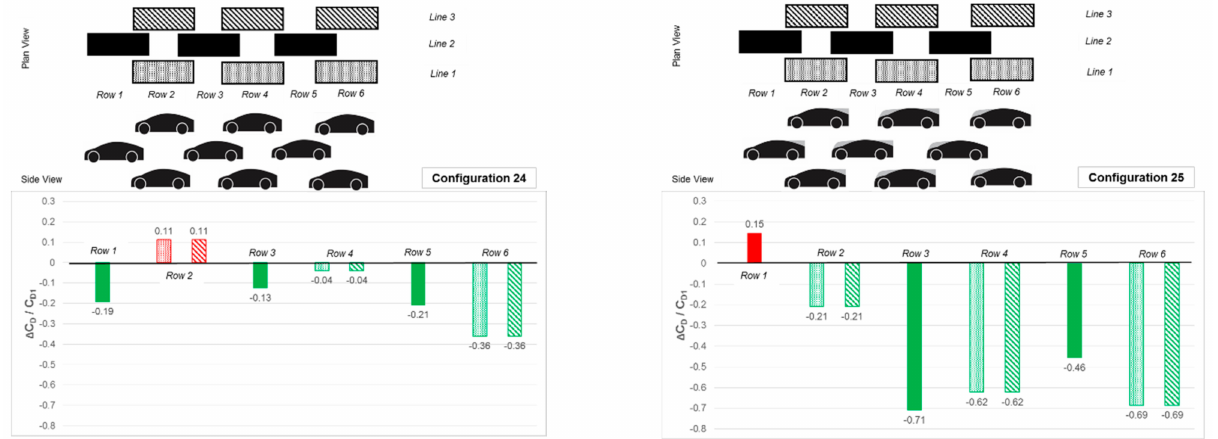
Figure 12. Triple-Line Stagger configuration of models. Configuration 24 comprising B1-styles. Configuration 25 comprising B2/B3/B4-styles.